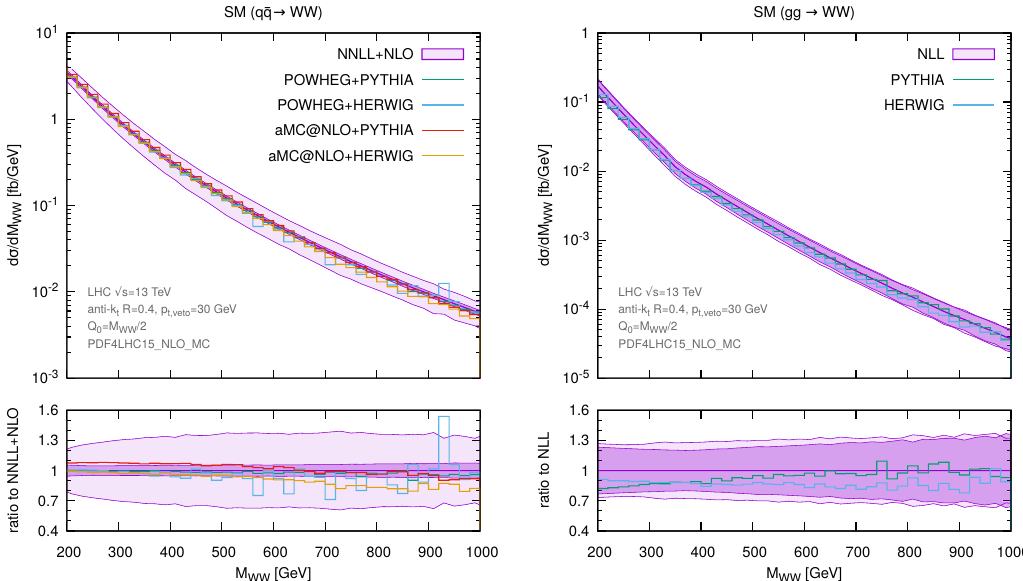
Figure 7 . Analytical predictions for the SM distribution in the invariant mass of a WW pair, compared to results from various parton-shower event generators, corresponding to the details given in the main